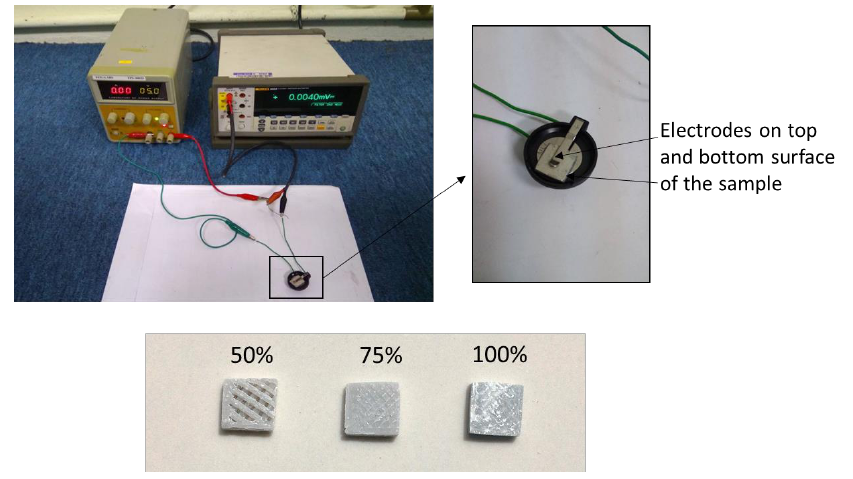
Figure 3. Electrical conductivity measurement setup.